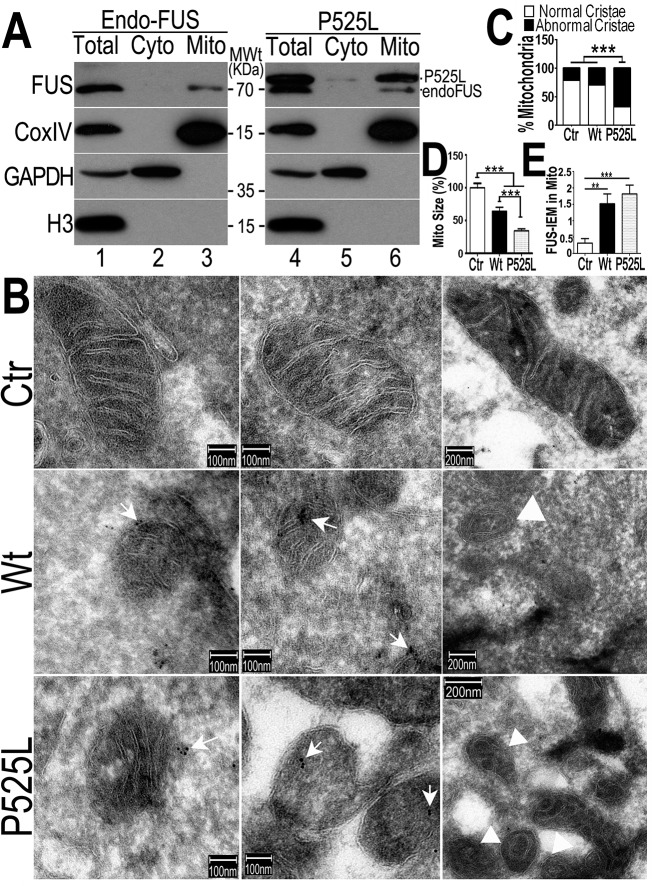
The FUS protein is associated with mitochondria.(A)Highly purified mitochondria were prepared from the control or P525L-FUS-expressing stable HEK cell lines. The mitochondrial purity was confirmed by the detection of mitochondrial CoxIV and the absence of the cytoplasmic proteins such as GAPDH or nuclear protein Histone H3. The endogenous FUS or P525L-mutant FUS localized to mitochondria; and the P525L-mutant FUS showed increased levels of mitochondrial localization (lane 6), as compared with the endogenous FUS in mitochondria (lane 3). (B-D) IEM images of the control or FUS-expressing stable HEK cell lines show reduced mitochondrial sizes in cells overexpressing FUS. Arrows, FUS-immunostaining signals associated with mitochondria labeled with 10-nm immuno-gold particles; arrowheads, mitochondria showed damaged cristae with “onion-like” structure. Mitochondrial cristae in P525L-mutant FUS expressing cells were significantly more frequently disrupted than the control and Wt-FUS groups, with quantification shown in panel C. More than 50 mitochondria were quantified in each group, analyzed using Chi-square test (***:p<0.0001).(D) Quantification of mitochondrial size using Image J. Mitochondria in Wt- or P525L-mutant FUS expressing cells were significantly smaller than the control group. At least 50 mitochondria were quantified in each group, analyzed using one-way ANOVA with Bonferronipost test (***: p<0.0001). (E) Mitochondrion-associated FUS immunostaining signals were significantly increased in Wt or P525L FUS expressing cells as compared with the Ctr. At least 60 mitochondria were quantified in each group, analyzed using one-way ANOVA with Bonferronipost test (**: p<0.01; ***: p<0.0001).